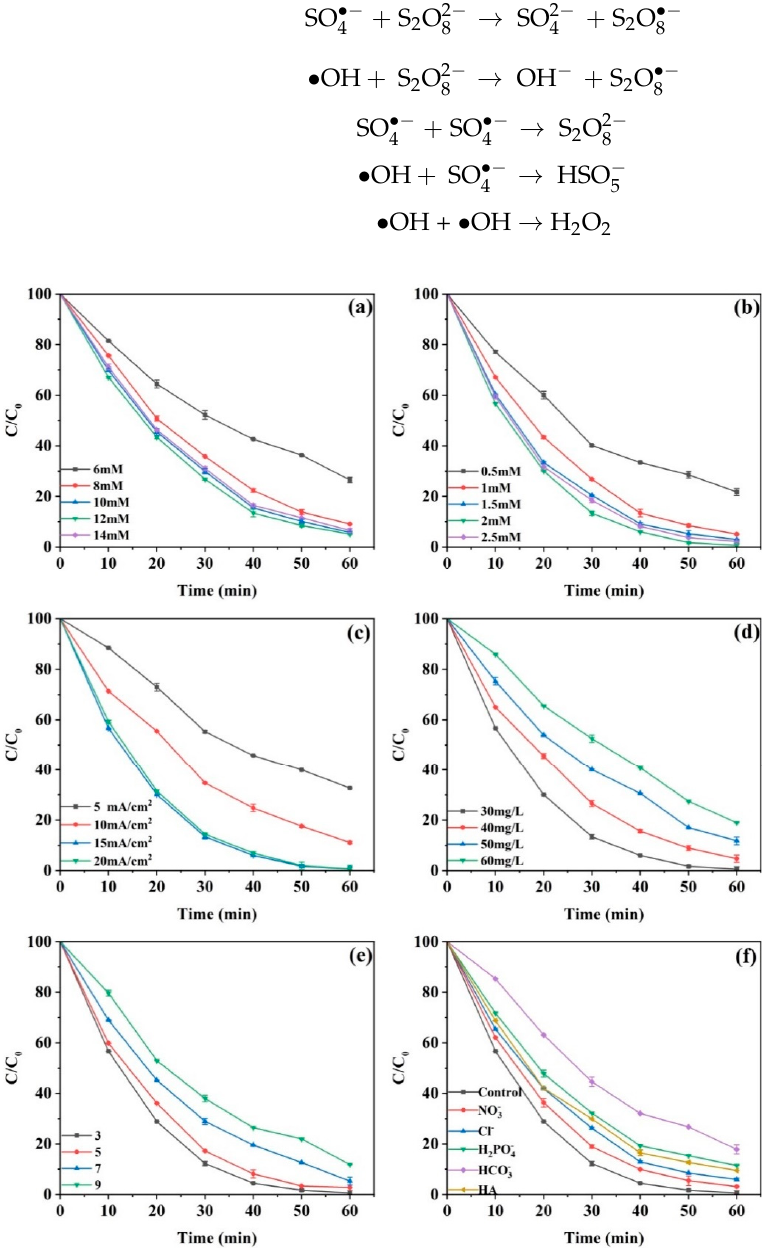
Figure 3. Effect of PDS concentration ( a ), Fe 3+ concentration ( b ), current density ( c ), initial IBU concentration ( d ), initial pH ( e ), inorganic anions and HA ( f ) on IBU removal. ((initial IBU concentration) = 30 mg/L, (Fe 3+ concentration) = 1 mM, current density = 15 mA/cm 2 , initial pH = 3; (initial IBU concentration) = 30 mg/L, (PDS concentration) = 12 mM, current density = 15 mA/cm 2 , initial pH = 3; (initial IBU concentration) = 30 mg/L, (Fe 3+ concentration) = 2 mM, (PDS concentration) = 12 mM, initial pH = 3; (Fe 3+ concentration) = 2 mM, (PDS concentration) = 12 mM, current density = 15 mA/cm 2 , initial pH = 3; (initial IBU concentration) = 30 mg/L, (Fe 3+ concentration) = 2 mM, (PDS concentra- tion) = 12 mM, current density = 15 mA/cm 2 ; (initial IBU concentration) = 30 mg/L, (Fe 3+ concentration) = 2 mM, (PDS concentration) = 12 mM, current density = 15 mA/cm 2 , initial pH =